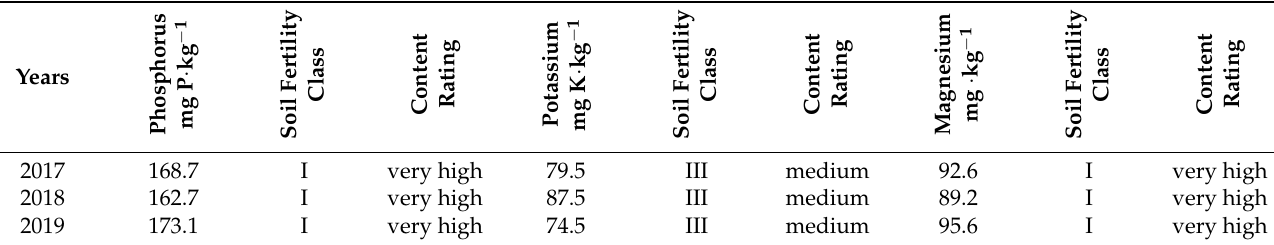
Table 6. Macronutrient soil content in the study years.